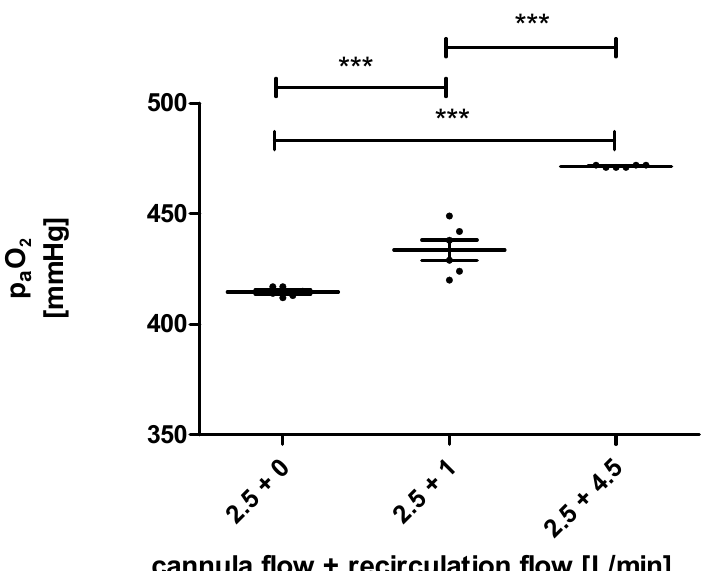
Figure 4. The measured oxygen pressure (p a O 2 ) at the arterial sensor of the ECMO for a cannula blood flow of 2.5 L/min and blood flows over the recirculation loop of 0 L/min, 1 L/min, and 2.5 L/min are highly significantly different (***).